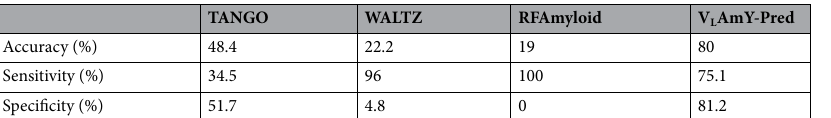
Table 2. Performance of aggregation-prone region prediction algorithms (TANGO and WALTZ), RFAmyloid and V L AmY-Pred on AL-Base dataset (1828 sequences). The presence of APRs in the variable region of light chain is considered amyloidogenic for TANGO and WALTZ. The V L AmY-Pred results are based on Leave one out